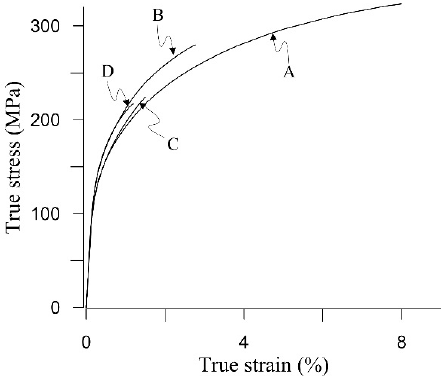
Figure 3. Typical tensile test curves for the four alloys with SDAS 10. The alloys are having the following sludge factors; A = 1.3, B = 1.8, C = 2.8, and D = 3.7. The samples are in as-cast conditions.